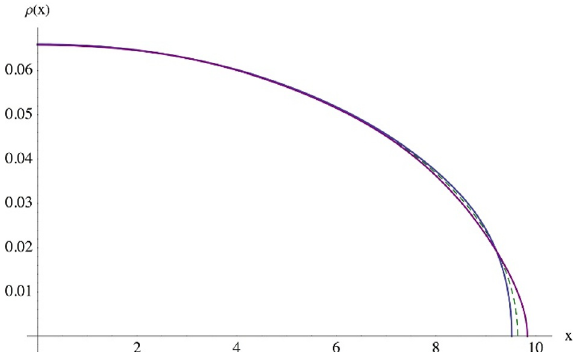
Figure 2 . The eigenvalue densities (cid:26) 1 (purple line) and (cid:26) 2 (blue line) obtained by numerically solving (2.6), (2.7) for (cid:21) 1 = 5320, (cid:21) 2 = 2797. The dashed line is the Wigner distribution with the e(cid:11)ective coupling (cid:21) = 3667. The density for the gauge group with a larger coupling ( (cid:26) 1 ) tends to spread more because the restoring force is weaker, hence (cid:22) 1 > (cid:22) 2 , but in spite of considerable disparity in the coupling strength the di(cid:11)erence between (cid:26) 1 and (cid:26) 2 is very small. This is the locking e(cid:11)ect. The di(cid:11)erence is most pronounced near the spectral edge. densities are given by the Wigner distribution whose width is determined by the